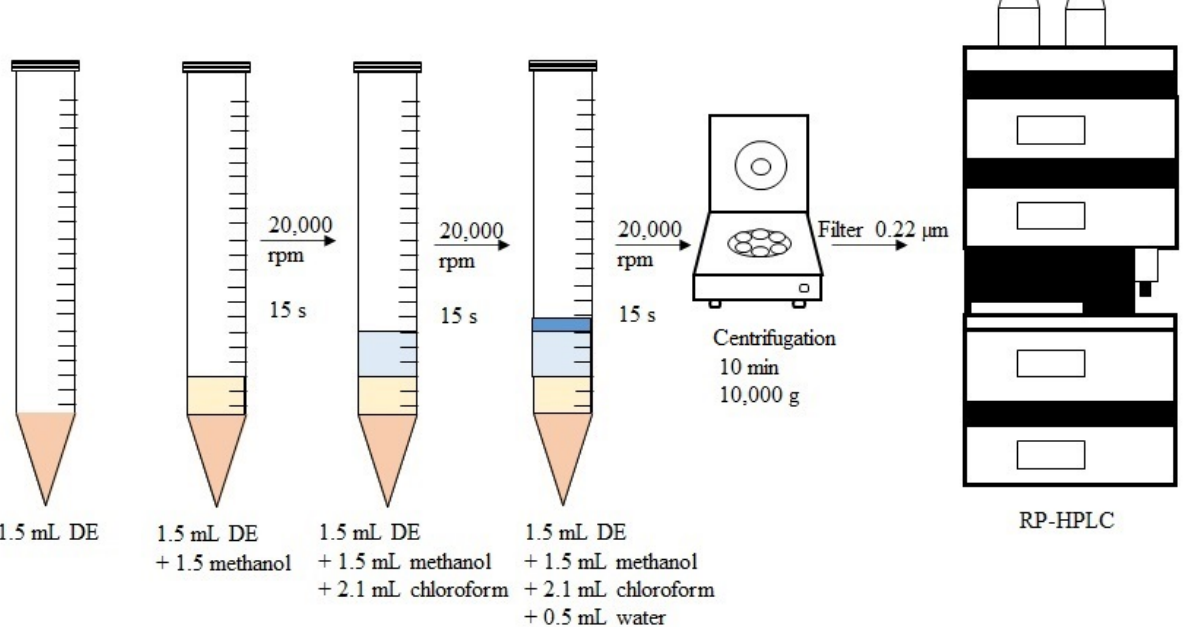
Figure 1. Schematic representation for determination of total punicalagin content in the DE. The mobile phase consisted of a mixture of (A) 0.4% acetic acid in Milli-Q water and (B) 100% acetonitrile with gradient elution at a flow rate of 1 mL/min. The step gradient started with 95% mobile phase (A) running 95% of mobile phase (B) in minute 37.